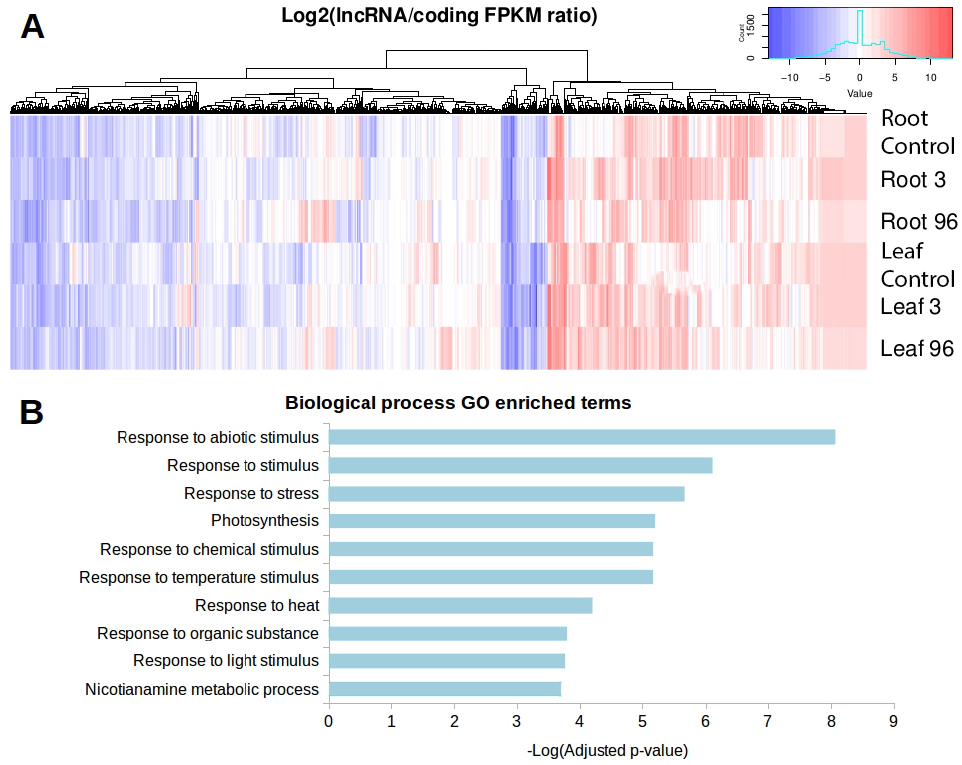
Figure 8. ( A ) Heat map representation of the expression ratio between differentially expressed trans -NAT lncRNAs and their respective target coding gene. In red, we have the pairs in which the lncRNA is overexpressed compared to their paired coding gene. In blue, the coding genes are overexpressed compared to their paired lncRNA; ( B ) ‘Biological process’ Gene Ontology enriched categories of differentially expressed trans -NAT lncRNAs.